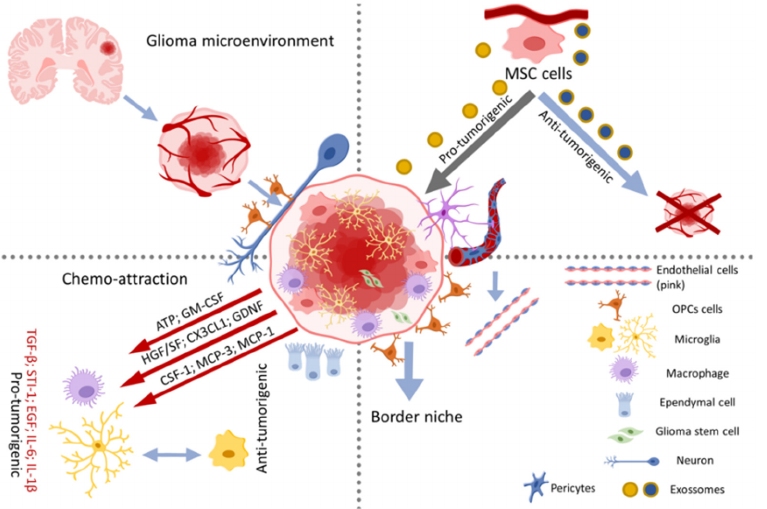
Figure 2. Glioma microenvironment. Interactions between healthy CNS cells and the perivascular system within the glioma. The tumor microenvironment is rich in tumor stem cells responsible for maintaining tumor progression and transformed glial cells (such as astrocytes and microglia), as well as other cells responsible for maintaining tumor angiogenesis (such as mesenchymal and perivascular cells). Tumor cells physically and chemically interact with other cells, such as neurons that impact the activity and functions of these cells. In the perivascular system, mesenchymal cells (MSCs) are recruited and release the content of pro-tumorigenic or antitumorigenic exosomes. In addition, pericytes are recruited for neovascularization in favor of the tumor. The macrophages residing in the CNS, the microglia, undergo chemoattraction and start to release pro-tumorigenic factors that help in the maintenance of the tumor. In addition, at the edge of the mass, GBM cells use oligodendrocyte progenitor cells (OPCs) and microglia to acquire characteristics such as stem cells, favoring tumor invasion. Chemo attraction factors: Granulocyte-Macrophage Colony-Stimulating Factor (GM-CSF), Fractalkine or chemokine (C-X3-C motif) Ligand 1 (CX3CL-1), Glial Cell Line-Derived Neurotrophic Factor (GDNF), Colony-Stimulating Factor 1 (CSF-1), Monocyte Chemoattractant Protein-1 (MCP-1) and (MCP-3).